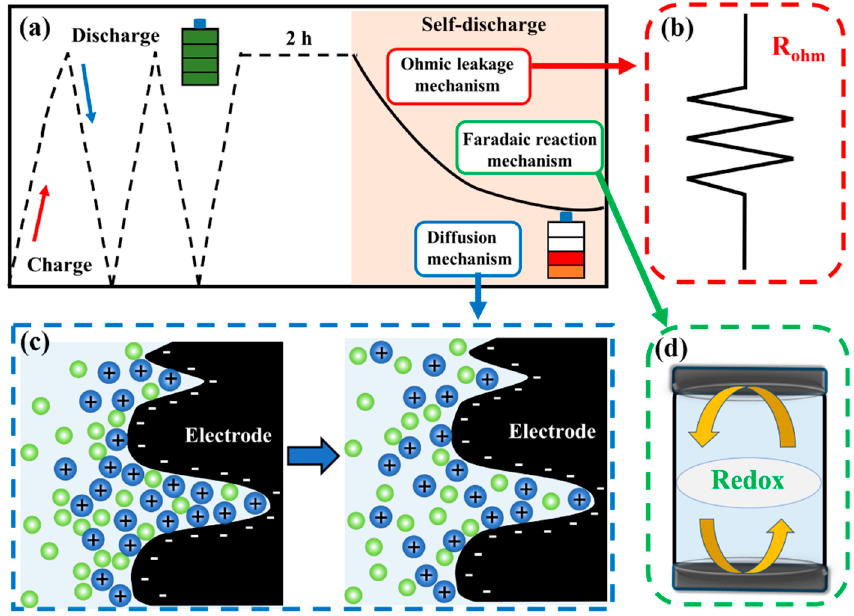
Figure 6. ( a ) Illustration of the experiment; The mechanisms of SDC in SCs: ( b ) ohmic leakage mechanism; ( c ) diffusion mechanism; and ( d ) Faraday reaction mechanism.